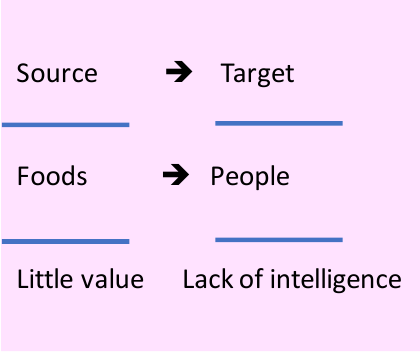
Figure 1. Metaphoric amalgam underlying the interpretation of ser un mendrugo/un berzas.